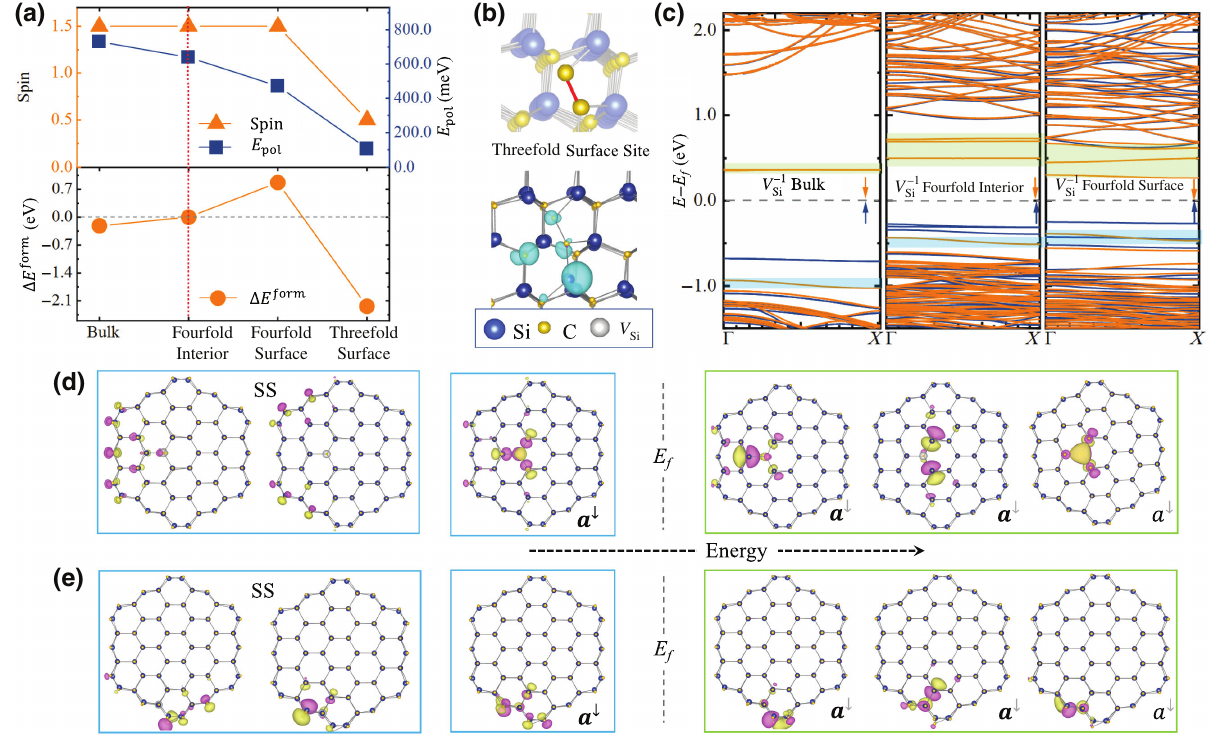
FIG. 3. A negatively charged silicon vacancy, V − 1 . (a) The site-dependent spin, spin polarization energy ( E pol = E nonmagnetic − Si E magnetic ), and formation energy, (cid:3) E form , of the defects at different sites in the NW. The defect-formation energy at the interior of at the threefold-coordinated surface site, showing dimerization the wire is used as the reference. (b) The equilibrium geometry for V − 1 Si of carbon atoms. The lower figure is a plot of the spin-density difference (in blue), showing the distribution of the spin of the defect . (c) Band structures (from left to right) for V − 1 created in bulk 2H-SiC, at the NW center, and the fourfold- on atoms around V − 1 Si Si coordinated site at the NW surface, respectively. The optically active (spin-down channel) defect states are highlighted. The Fermi energy, E f , is used as the reference. Charge-density plots for the optically active defect states (energy ordered) for the defect at (d) the NW center and (e) the fourfold-coordinated site on the NW surface. Also shown are donorlike surface states (SSs) that are just below the filled defect states and that show a hybrid defect-surface-state character. The pink (yellow) color corresponds to positive (negative)